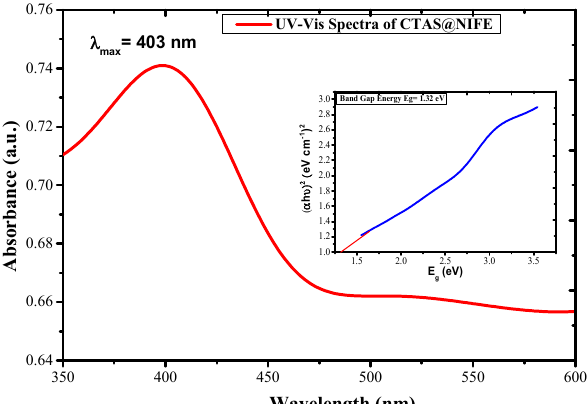
Figure 4. UV-Vis plot of chitosan-ascorbic acid@NiFe 2 O 4 in wavelength range of 350–600 nm (inset shows Tauc’s plot for calculating the band gap energy (E g ) of the material).